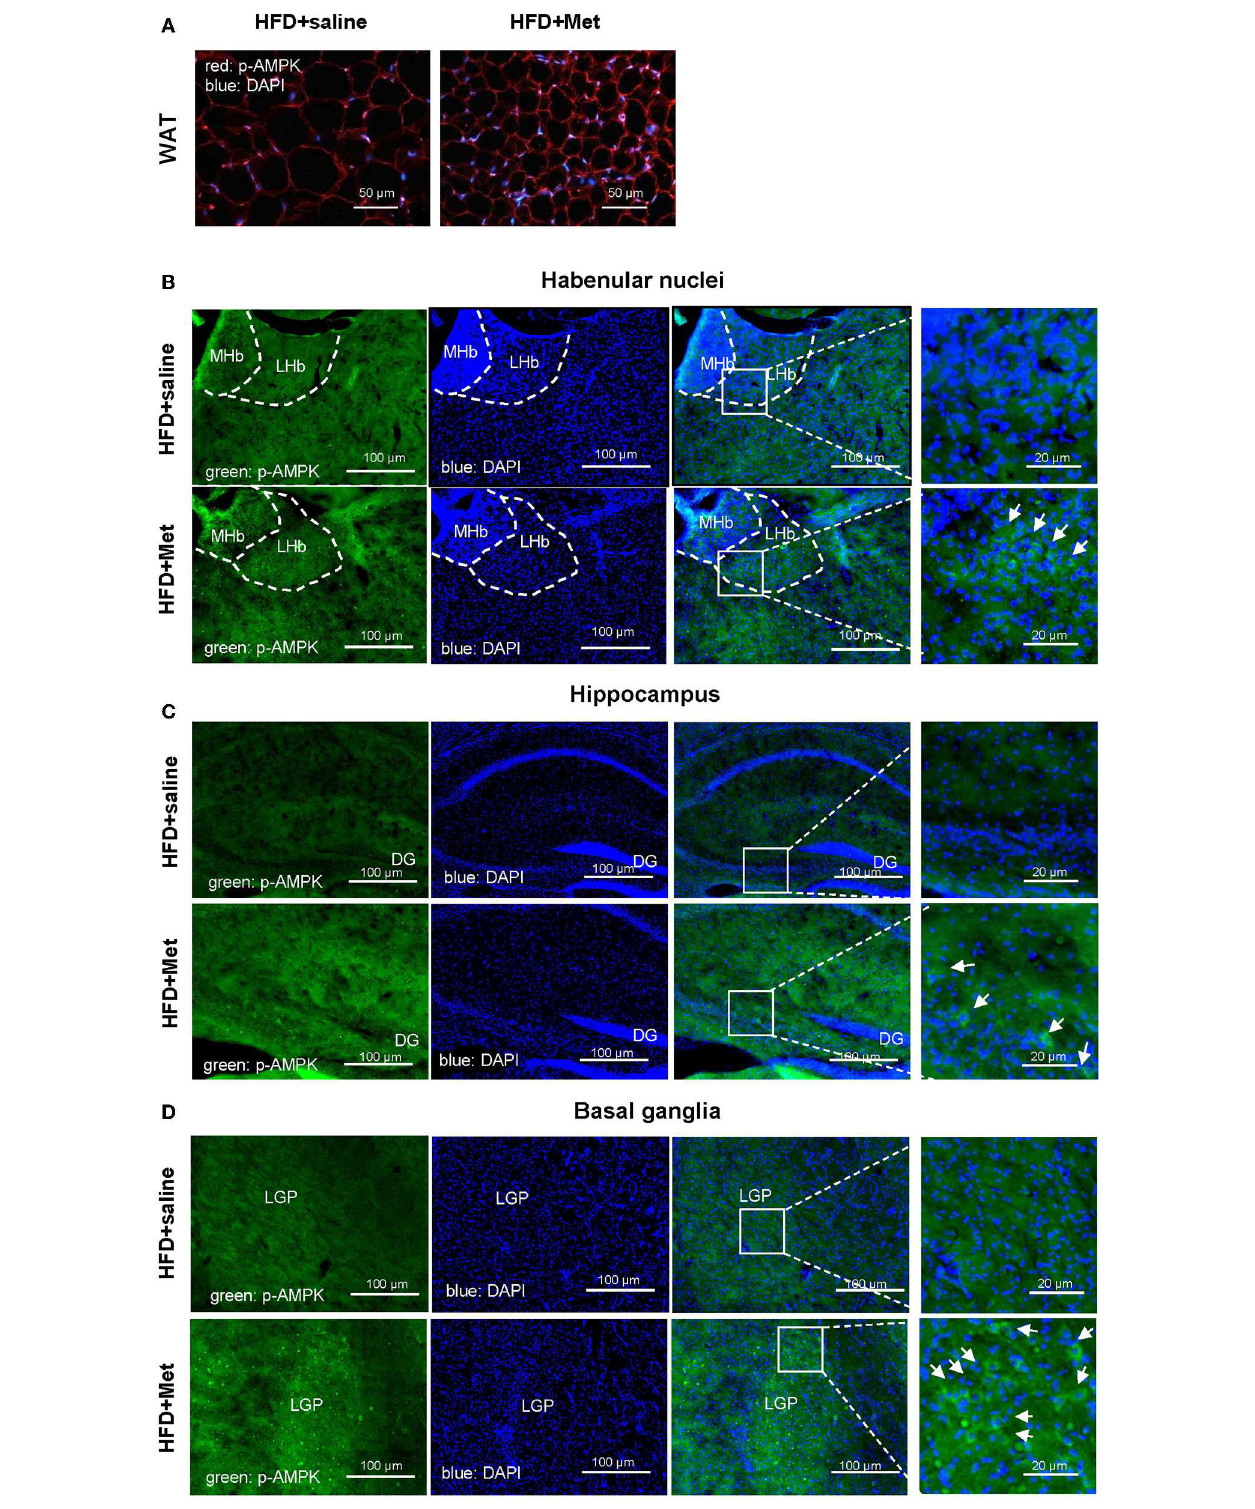
FIGURE 4 | Metformin co-treatments showed stronger pAMPK immunostaining in the WAT and in the habenular nuclei, hippocampus and basal ganglia of the brain. Compared with HFD group, HFD + Met group showed stronger pAMPK staining in the adipocytes ( A ; red, pAMPK, blue, DAPI; scale bars, 50 µ m) and in the habenular nuclei, hippocampus and basal ganglia [for (B–D) , green, pAMPK, blue, DAPI, scale bars, 100 and 20 µ m, respectively; MHb, medial habenula nucleus; LHb, lateral habenular nucleus; DG, dentate gyrus; LGP, lateral globus pallidus; for (A–D) , n = 3 per group].